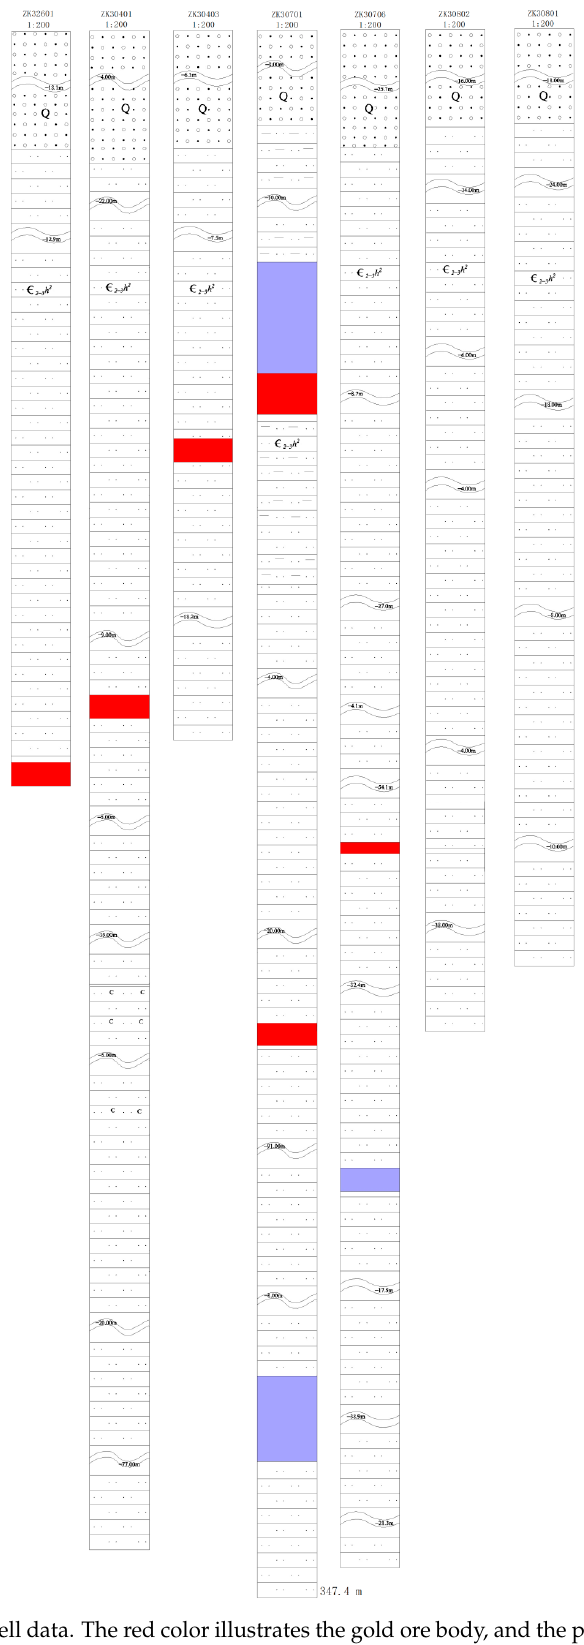
Figure 13. Drilling well data. The red color illustrates the gold ore body, and the purple color illustrates the gold mineralization.